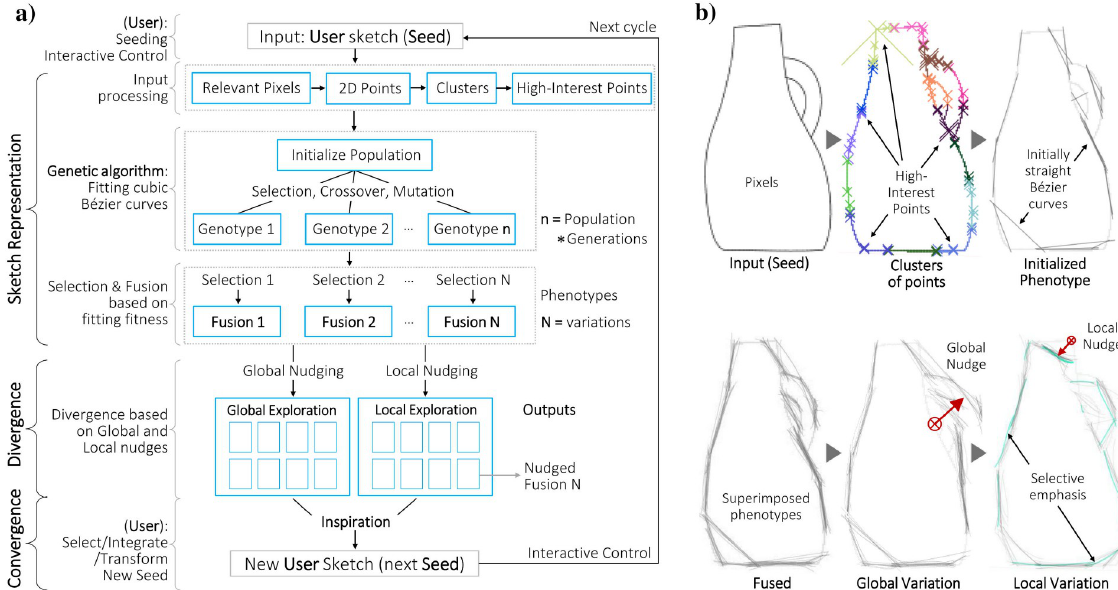
Fig 4. The approach. a) The general approach proposed to assist early shape divergence and exploration in a human-AI collaboration. Note that the human collaborator provides the Seed and the shape reinterpretation at the end of every cycle. b) An example shape starting with a given Seed and leading to suggested global and local variations with a rough sketch style.